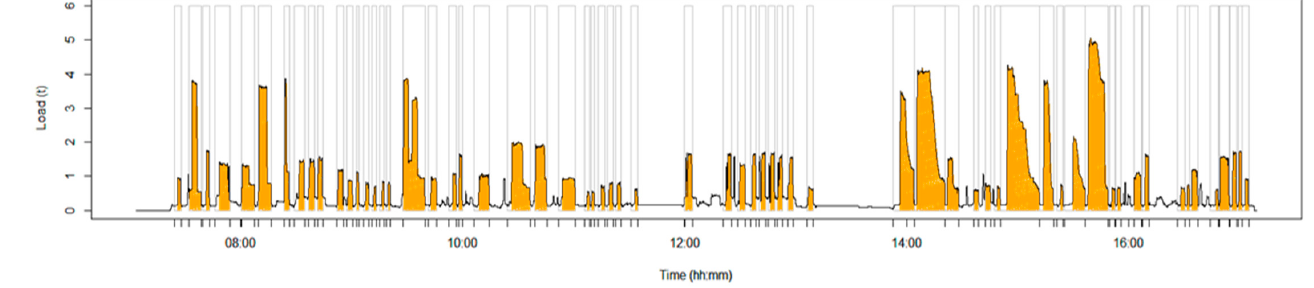
Figure 4. Segmentation visualization of load signal.